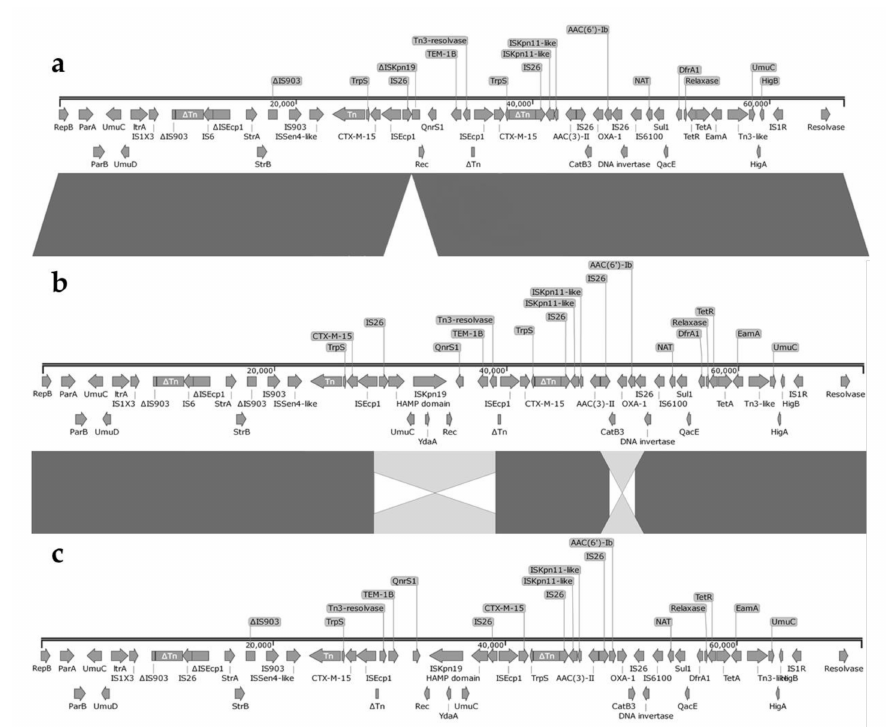
Figure 3. Major structural features of the IncR plasmids, pHKP0018.2 ( a ), pHKP0064.2 ( b ) and Arrows indicate the deduced open reading frames (ORFs) and their orientations. Hypothetical proteins are not shown. The figure was generated with EasyFig 2.1